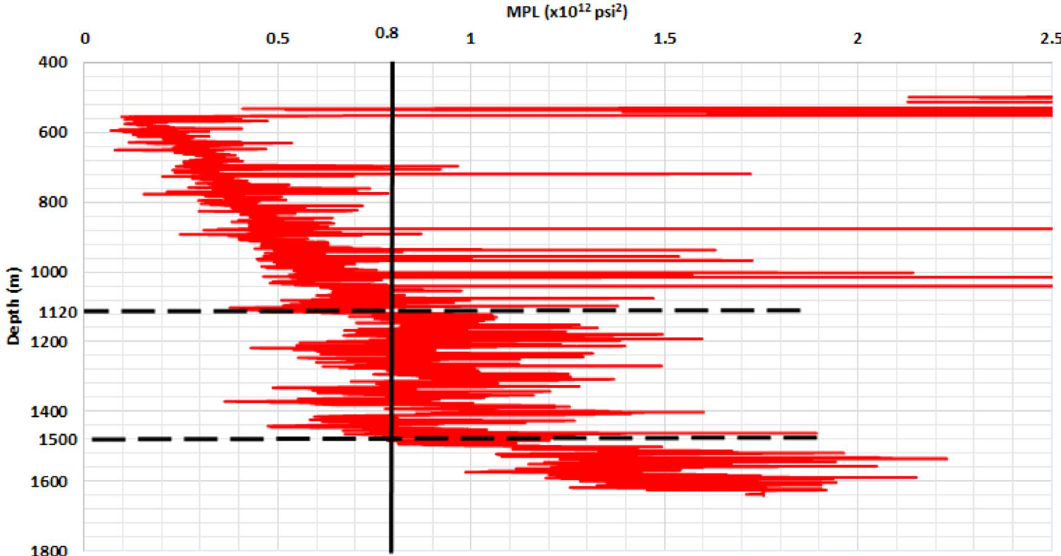
Fig. 11 MPL value of Field